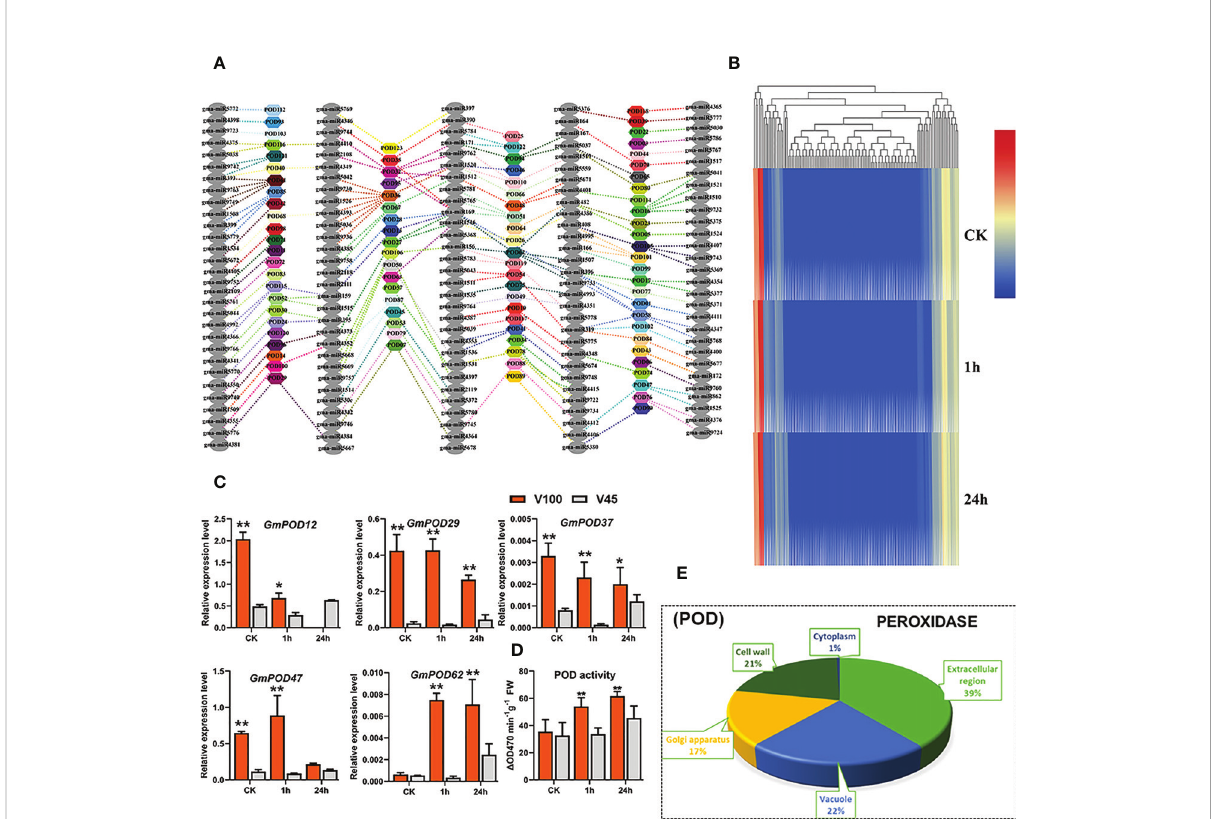
FIGURE 7 GmPOD genes and posttranscriptional regulation in V100 and V45. (A) Post-transcritpional regulation of GmPOD by gma-miRNA. (B) RNA-seq expression analysis of GmPOD genes under control (CK) and cold stress conditions. Expression data was normalized by log2FC. (C) qRT-PCR veri fi cation of GmPOD genes in V100 and V45. (D) POD enzyme activity in V100 and V45. (E) Gene ontology analysis of GmPODs. Data was analyzed with the Statistix 8.1. The ** and * asterisks indicate the signi fi cant differences at p-value <0.01 and p-value <0.05,